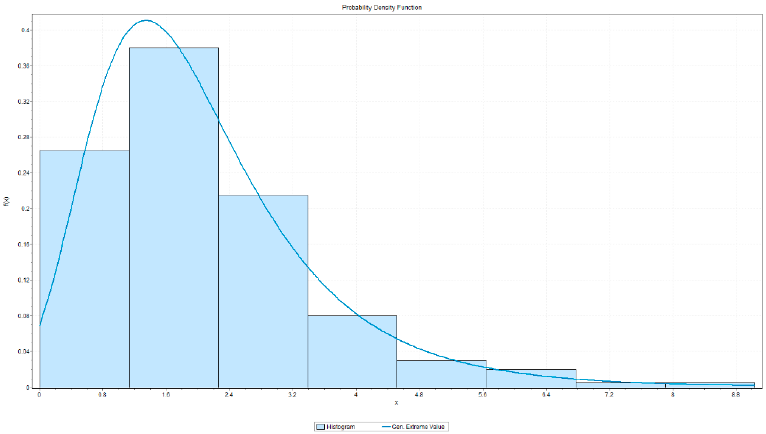
Figure 9. Generalized Extreme Values distribution fit to the output Yield from PAWN method.